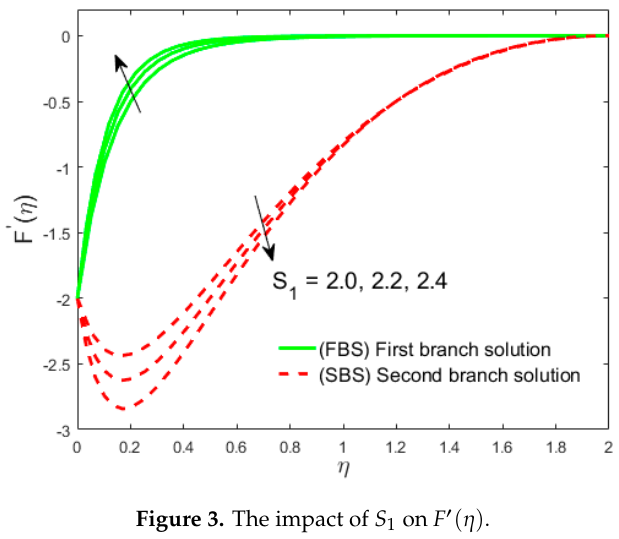
Figure 3. The impact of 1 S on